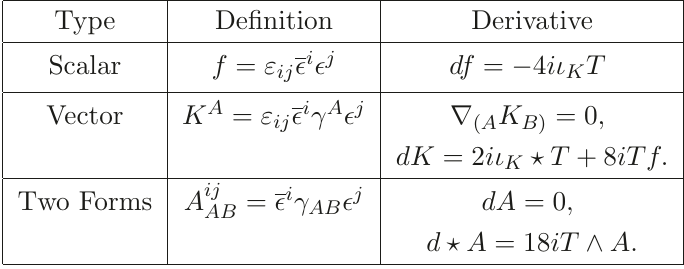
Table 1 . Summary of the differential relations between Killing Spinor